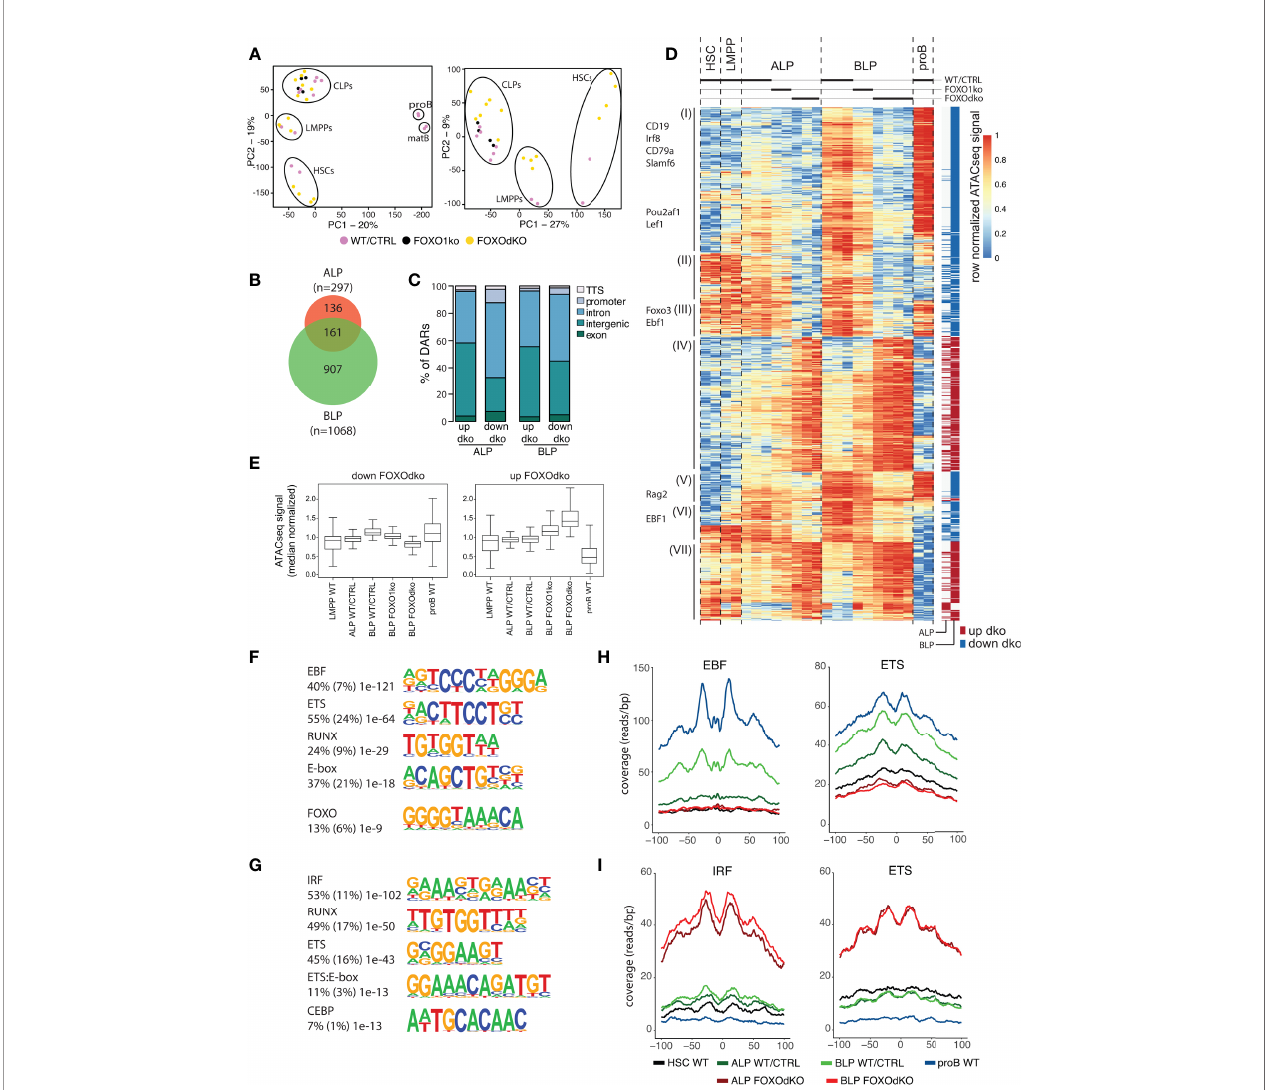
FIGURE 5 | Chromatin accessibility is altered by the lack of FOXO. (A) Principal component analysis of ATACseq data. (B) Venn diagram displaying the overlap between differentially accessible regions (DARs) (adjusted p-value <0.01 and 2-fold change comparing FOXOdko to WT/CTRL and ≥ 30 reads in at least two samples) in the FOXOdko at the indicated CLP stage. (C) Bar graph illustrating distribution of DARs amongst indicated genomic locations. (D) Hierarchical clustering of ATACseq signal in DARs. The stage where a signi fi cant change occurs is indicated to the right. DAR proximal genes are indicated to the left. (E) Median normalized ATACseq signal in DARs with decreased (left) and increased (right). (F, G) De novo motif enrichment in DARs with decreased (F) and increased (G) ATACseq signal in FOXOdko BLP. Percentage of sequences containing the motif, percentage of background sequences containing the motif (in parenthesis) and p-value of the enrichment are displayed to the left of the enriched motifs. (H, I) Transposase integration-based cut-pro fi les of DARs with: (H) decreased ATACseq signal containing EBF and ETS binding sites; or (I) increased ATACseq signals containing IRF and ETS binding